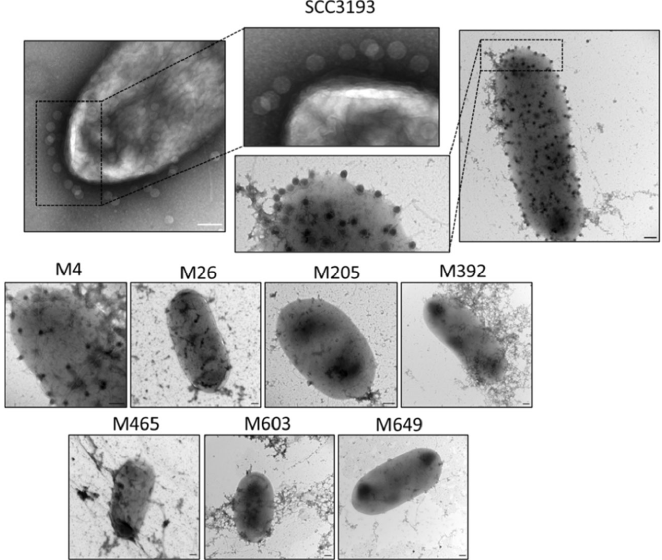
Figure 2. Visualization of adsorption of φ A38 phage particles to wild-type P. parmentieri and phage- resistant mutants by transmission electron microscopy (TEM). Bacterial cells and phage particles were mixed at MOI of 10 and incubated for 20 min at 20–22 °C to allow the phages to attach to host cells. At least 10 individual images were collected for each strain, and the experiment was repeated once (two biological replicates of the assay). Representative photos are shown. Scale bar—200 nm.